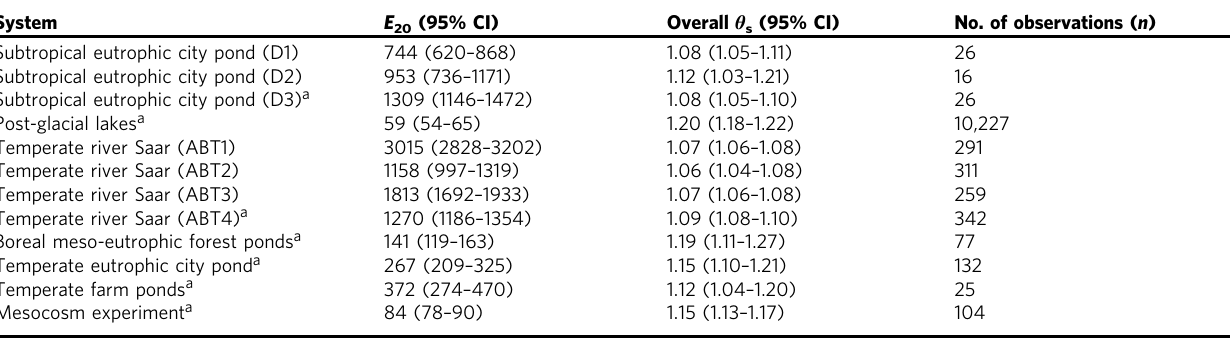
Table 1 Temperature dependence of CH 4 ebullition in different freshwater ecosystems